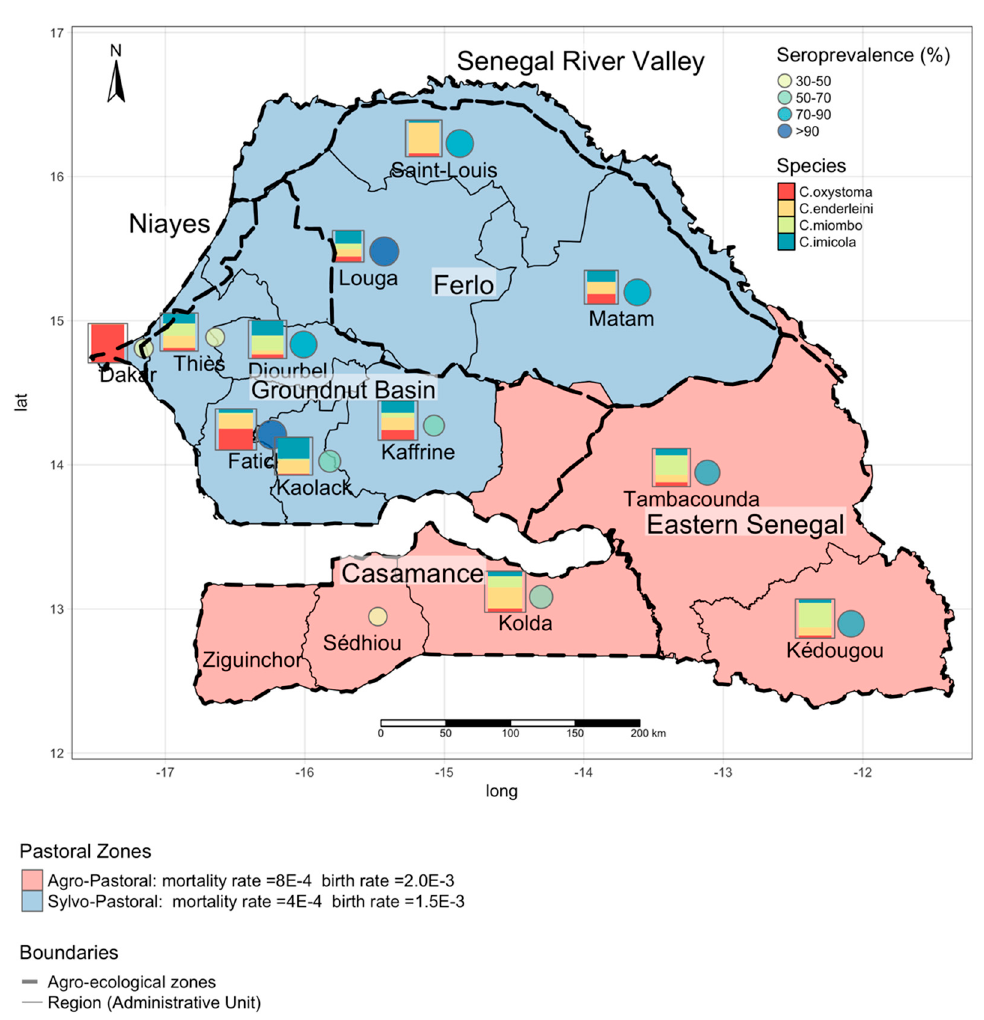
Figure 1. Seroprevalence, entomological, and demographic data. The circles show regional BT seroprevalence based on data collected during the national sero-survey in 2018. The squares show the distribution of the four Culicoides species of interest; the square’s size is proportional to the logarithm of the number of Culicoides collected during the national entomological survey in 2012. The background colors (red and blue) delimit the two pastoral zones with different birth and mortality rates. Dashed lines delimit the six agro-ecological zones in Senegal (Ferlo, Senegal River Valley, Eastern Senegal, Casamance, Groundnut Basin, Niayes), while the thin solids lines identify the administrative regions .